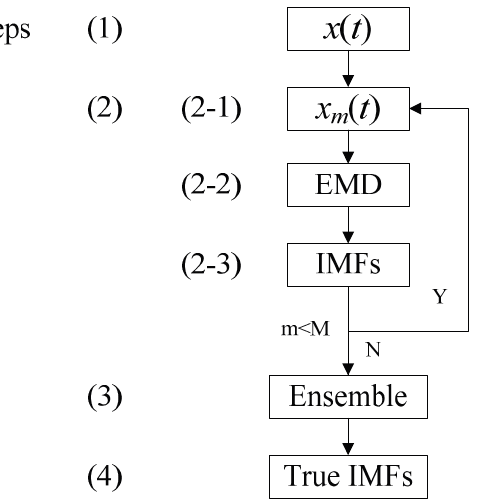
Figure 1. Flow of ensemble empirical mode decomposition